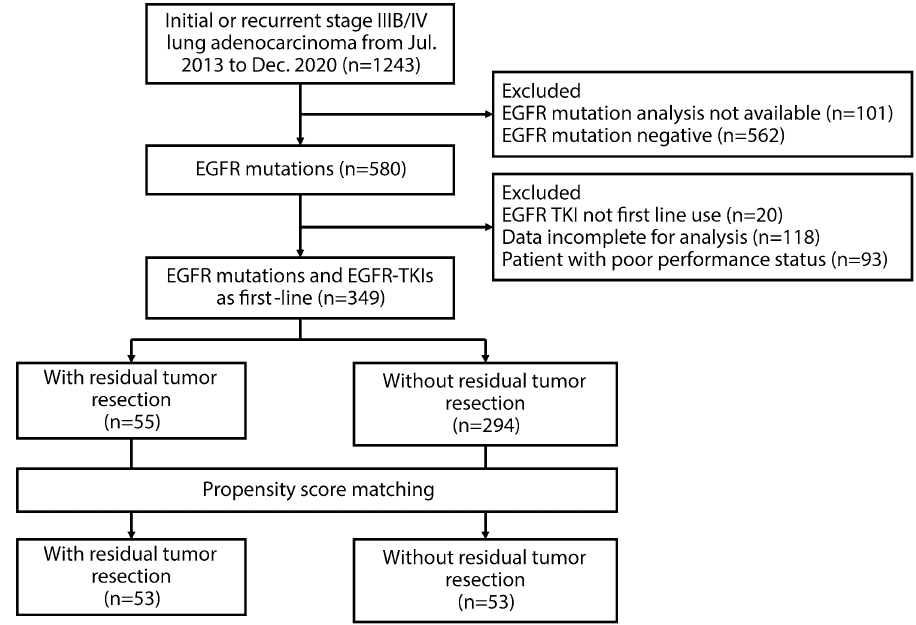
Figure 1. Flowchart for patient enrollment. EGFR epidermal growth factor receptor, NSCLC non ‐ small cell lung cancer, TKI tyrosine kinase